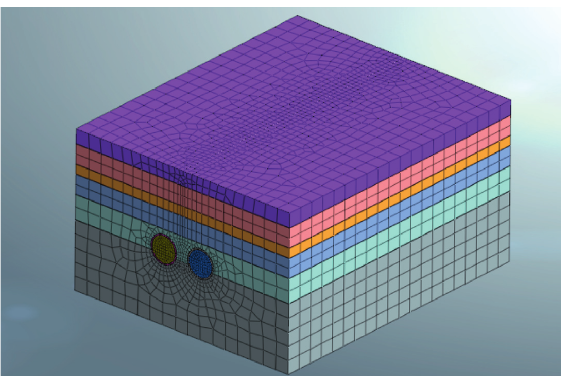
Figure 9: Finite element model. Table 1: Geotechnical physical and mechanical